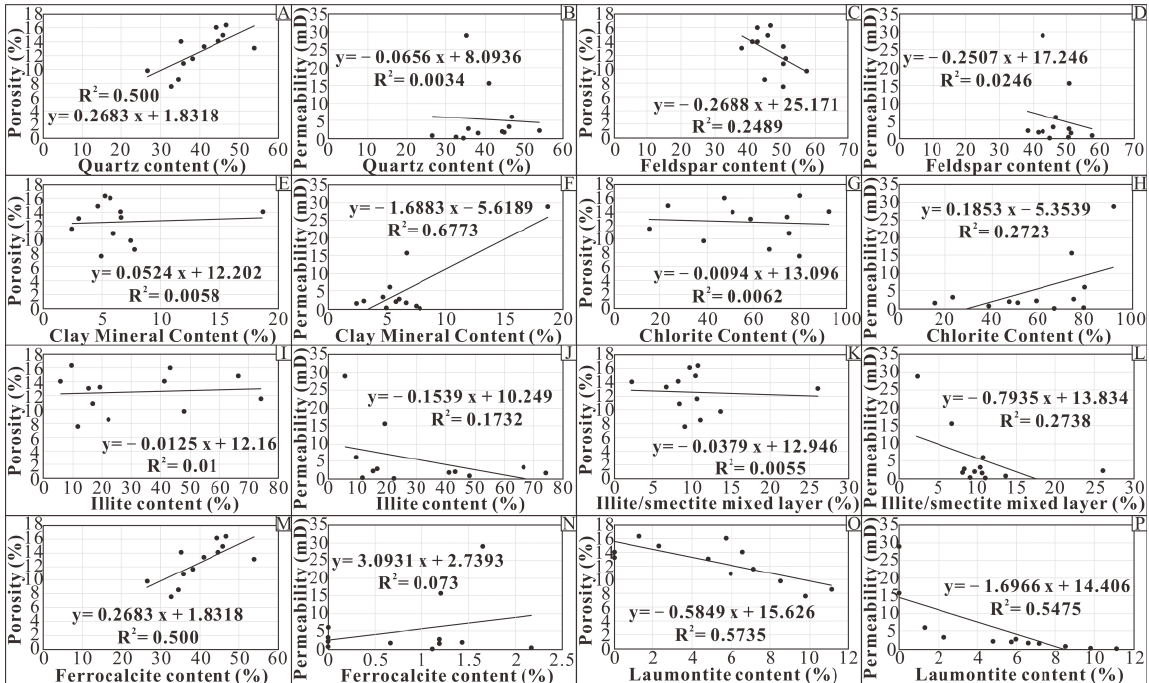
Figure 17. Correlation between mineral composition and reservoir quality. ( A , B ) Correlation between quartz content with physical properties. ( C , D ) Correlation between feldspar content with physical properties. ( E , F ) Correlation between clay mineral content with physical properties. ( G , H ) Correlation between chlorite content with physical properties. ( I , J ) Correlation between illite content with physical properties. ( K , L ) Correlation between I/S mixed layer content with physical properties. ( M , N ) Correlation between ferro-calcite content with physical properties. ( O , P ) Correlation between laumontite content with physical properties.